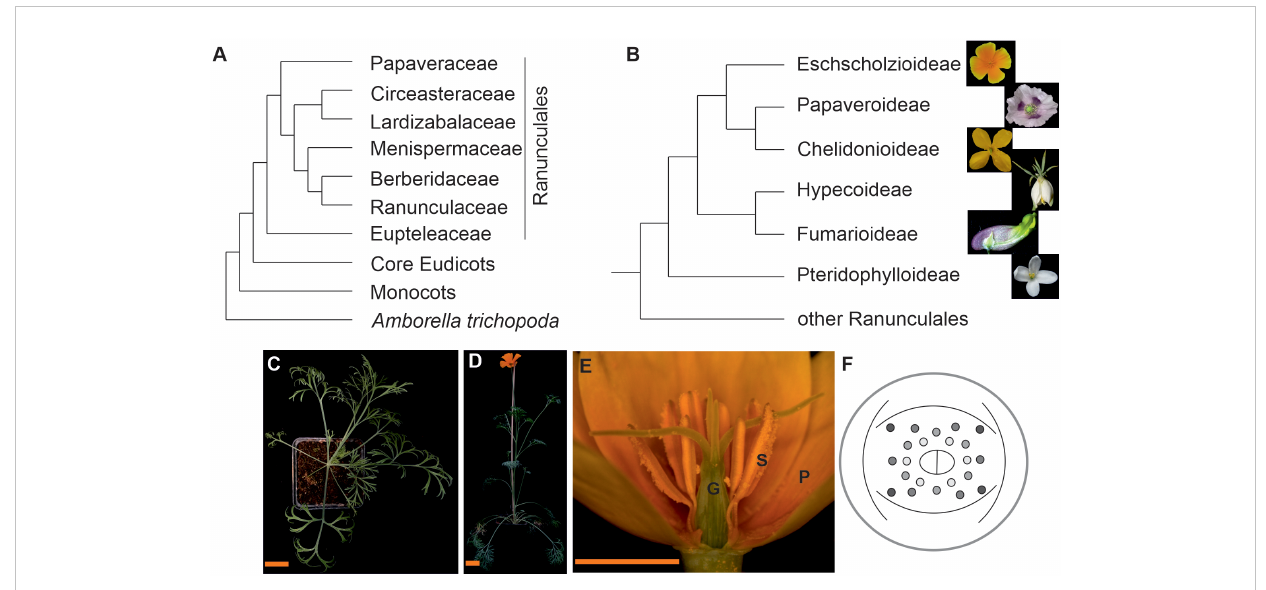
FIGURE 1 Simpli fi ed angiosperm phylogenies focusing on the phylogenetic position and morphology of California poppy. (A) Phylogeny of the Ranunculales [according to Lane et al. (2018) and Hoot et al. (2015)], (B) phylogeny of the Papaveraceae s.l. on subfamily level based on Hoot et al. (2015). Fotos next to the branches show subfamily representatives, from top to bottom California poppy , Papaver somniferum, Chelidonium majus , Hypecoum leptocarpum , Capnoides sempervirens, Pteridophyllum racemosum. (C) top view on California poppy in its vegetative phase, (D) side view of a fl owering plant, (E) side view of a California poppy fl ower (G, gynoecium; P, petal; S, stamens) and (F) fl oral diagram showing the sepal cap, two whorls of petals, several whorls of stamens and a bicarpellate gynoecium (photos are from Dominik Lotz and Doudou Kong, Gießen, Germany, and Natalia Pabon-Mora, Medellin, Colombia). The size bar in C and D correspond to 3 cm, the size bar in E is 1